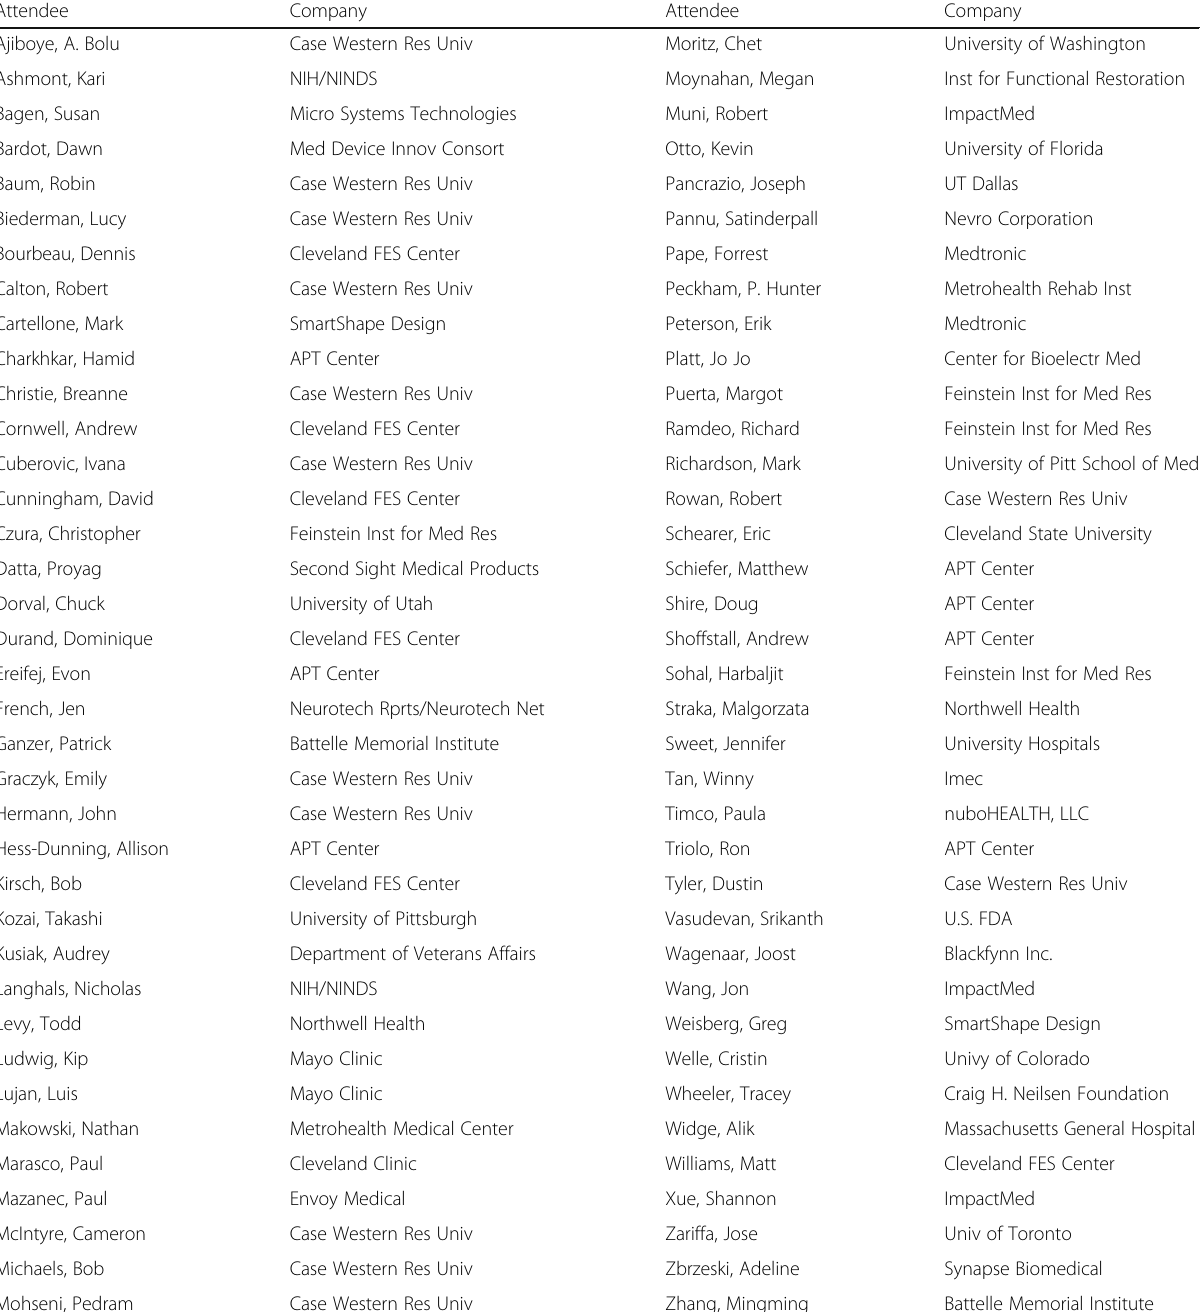
Table 2 Attendees of the 2017 Cleveland Neural Engineering Workshop